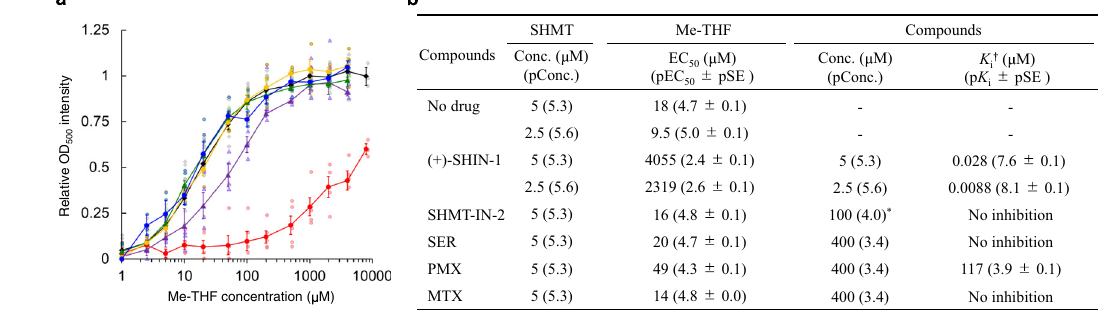
Fig. 4 Competitive binding assay results. a OD 500 values with each concentration of Me-THF and 5 μ M of efm SHMT in the presence and absence of each compound (black; No drug, red; ( + )-SHIN-1, purple; PMX, green; MTX, yellow; SER and blue; SHMT-IN-2). Grey-, dark yellow- and light-coloured symbols show the values for calculating the average values and standard error (SE) of each point. The n number for No drug is ten ( n = 3 at 8000 μ M of Me-THF, n = 9 at 2000 and 4000 μ M of Me-THF and n = 10 at other data points). The data point for SHMT-IN-2, SER, PMX and MTX is four ( n = 4). The n number for ( + )-SHIN-1 is fi ve ( n = 3 at μ M of Me-THF, n = 4 at 2000 and 4000 μ M of Me-THF and n = 5 at other data points). Addition of ( + )-SHIN-1 and PMX suppressed Me-THF binding to efm SHMT. b K i of each compound and other values, which were used for calculating Ki, are shown. Stronger K i were observed at the lower efm SHMT concentrations used. All experiments were performed in the presence of 10 mM Gly and 100 μ M Ser. These experiments were performed three to ten times. pEC 50 , pConc and p K i are log-transformed EC 50 , Conc. and K i , respectively.